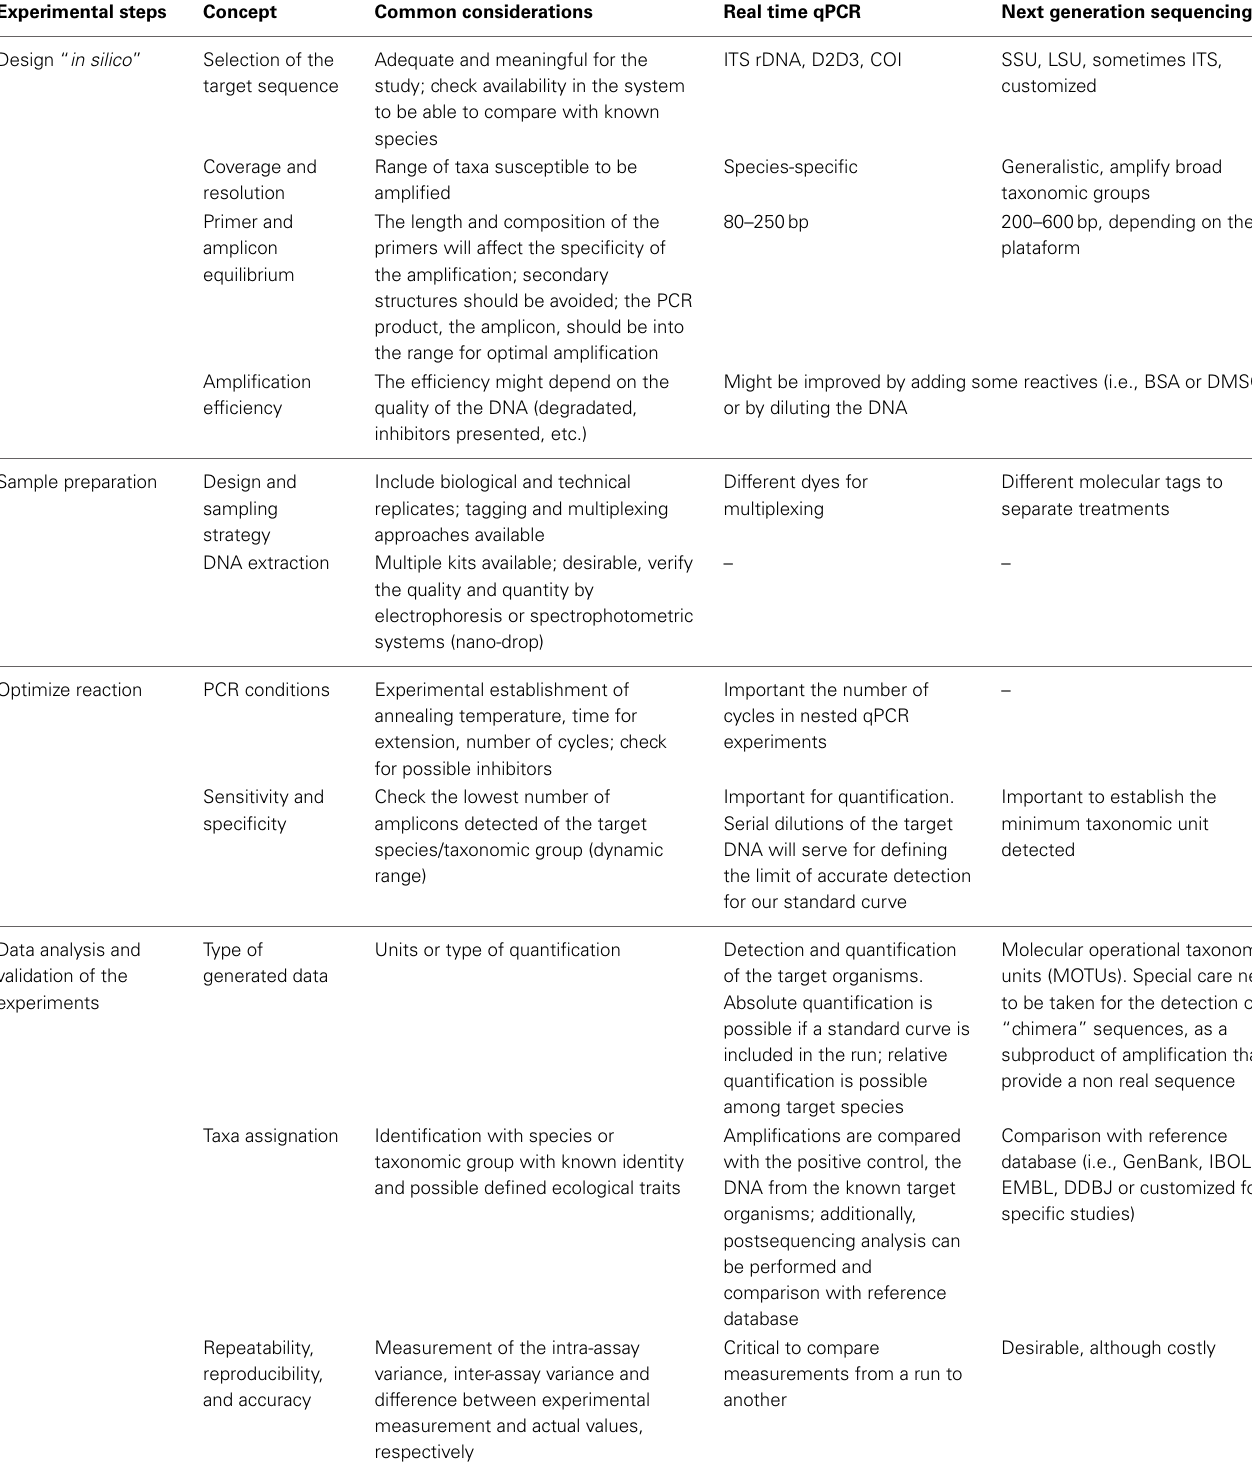
Table 2 | General considerations for the development of PCR-based methods (from Bustin et al., 2009; Campos-Herrera et al., 2010; van Pelt-Verkuil et al., 2010; Pompanon et al., 2012) and comparison between the two most extended methods in belowground studies: real time qPCR and DNA barcoding using next generation